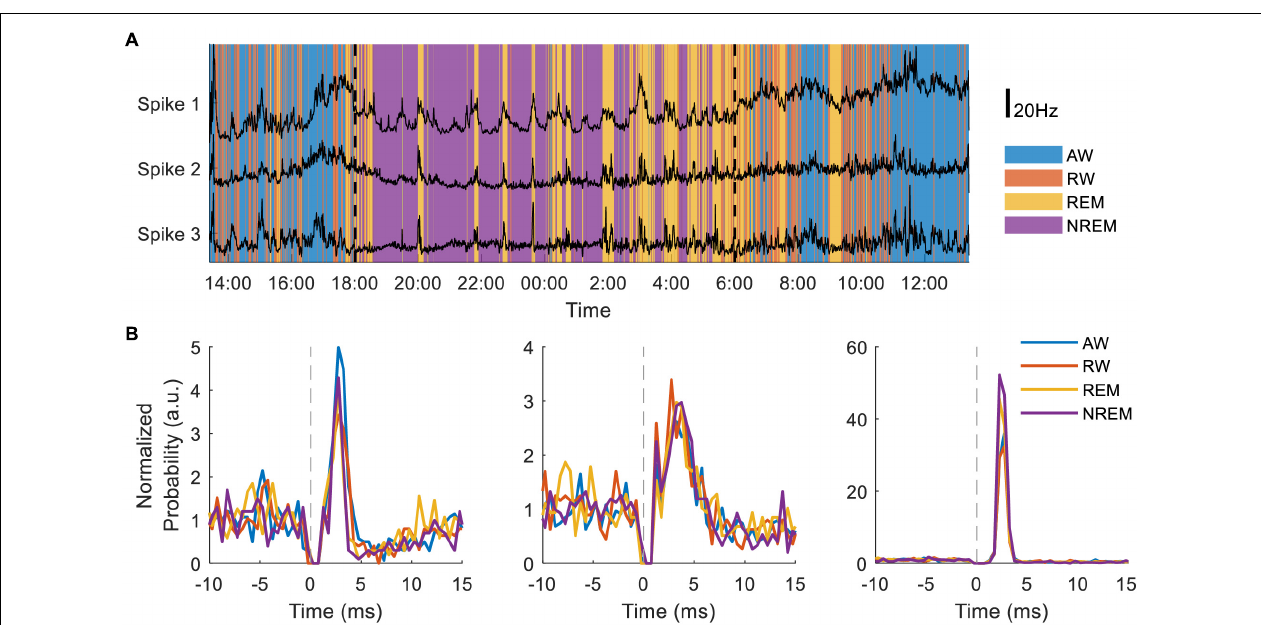
FIGURE 10 | Long-term recording of multiple neurons during sleep and wake. (A) Neural firing rates of three neurons recorded for 30 h during four putative behavioral states: active-wake (AW, blue); resting-wake (RW, orange); rapid eye movement sleep (REM, yellow); and non-REM sleep (NREM, purple). During the time between the two vertical dashed lines the animal room light was turned off (18:00–6:00). (B) Peristimulus time histograms normalized to average firing rate of three different neurons during the four classified states.